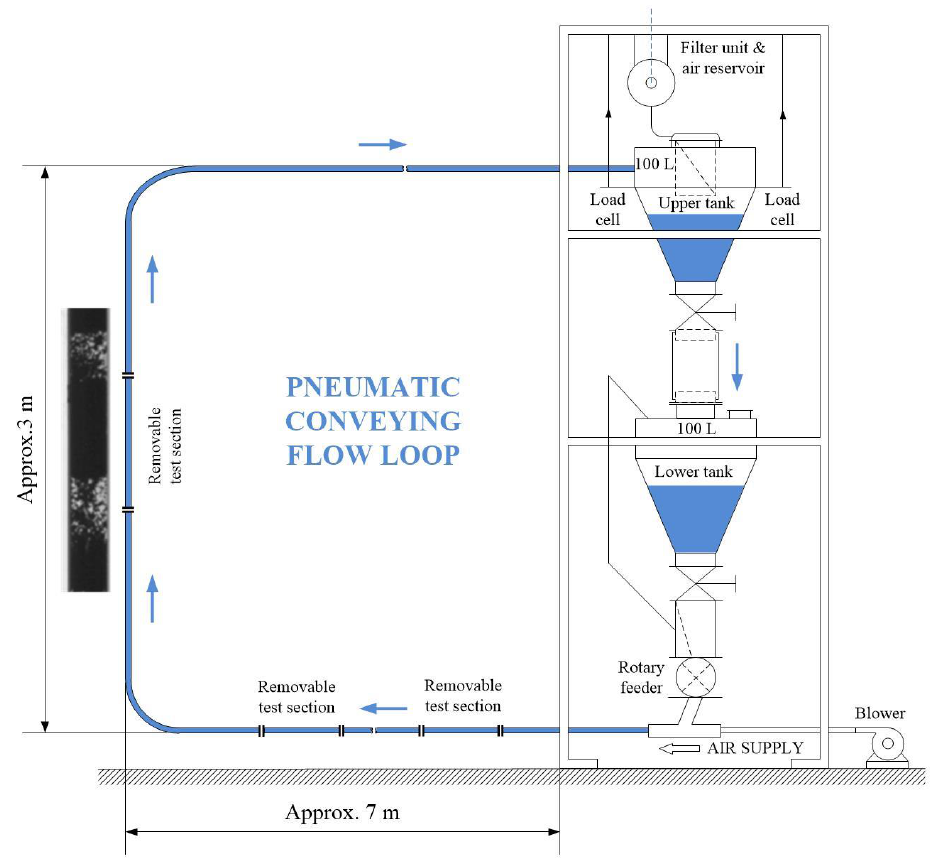
Figure 8. Gravity drop rig schematic ( right ) and image captured by a CCD camera installed closed to transparent removable test section ( left ).